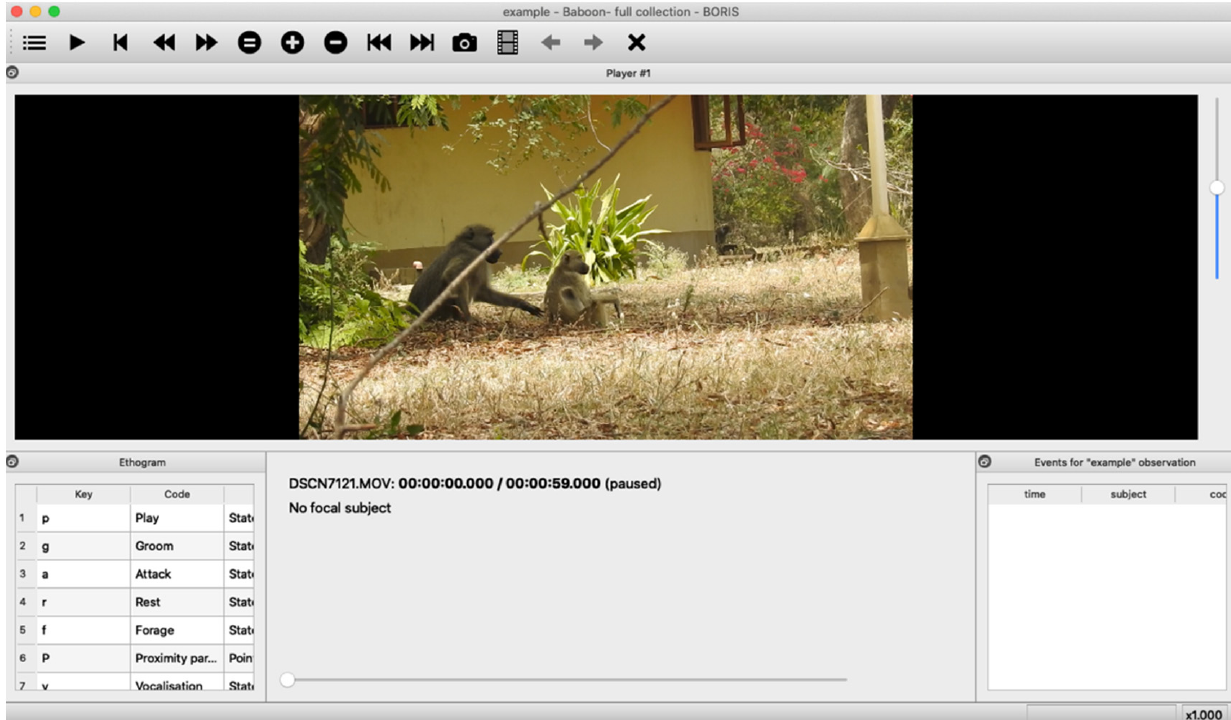
Figure 2. Screenshot of BORIS software .